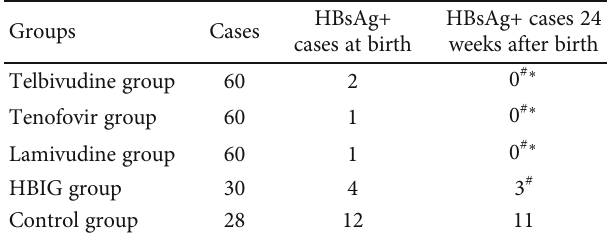
Table 3: HBsAg status in